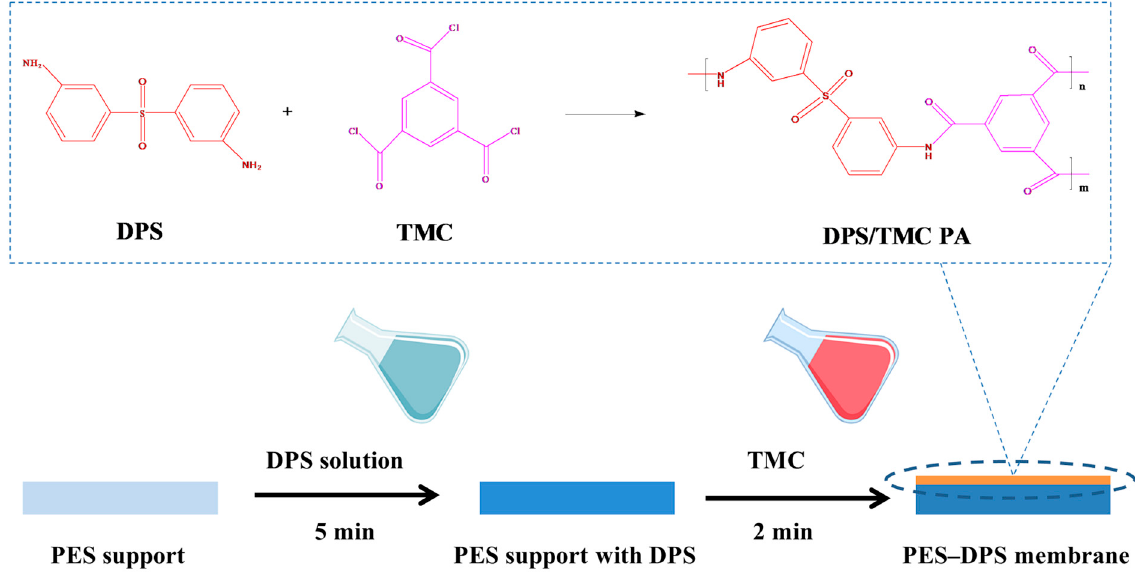
Figure 1. Schematic illustration of the fabrication process of the PES–DPS loose TFC NF membranes (The orange section in the PES-DPS membrane corresponds to DPS/TMC PA, while the blue section corresponds to PES support).